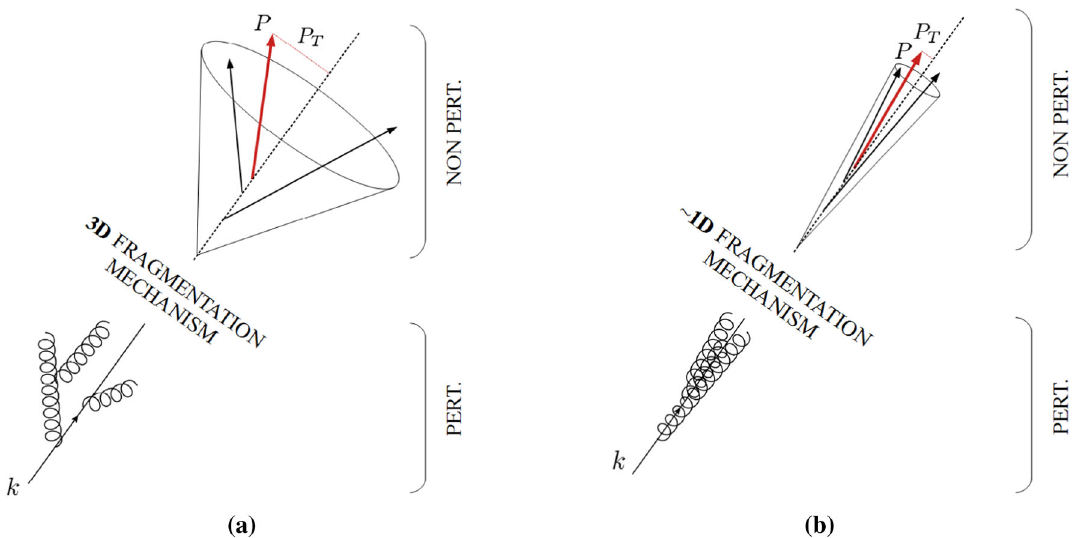
Fig. 3 Pictorial representation of a TMD Fragmentation Function, in which the separation between perturbative and non-perturbative regime isexplicitlyshown, correspondingtotwodifferentvaluesoftherapidity cut-off. In a the rapidity cut-off of the TMD FF is set to a generic value y 1 . In b the rapidity cut off has been shifted to (cid:6) y 1 > y 1 . The two TMDs